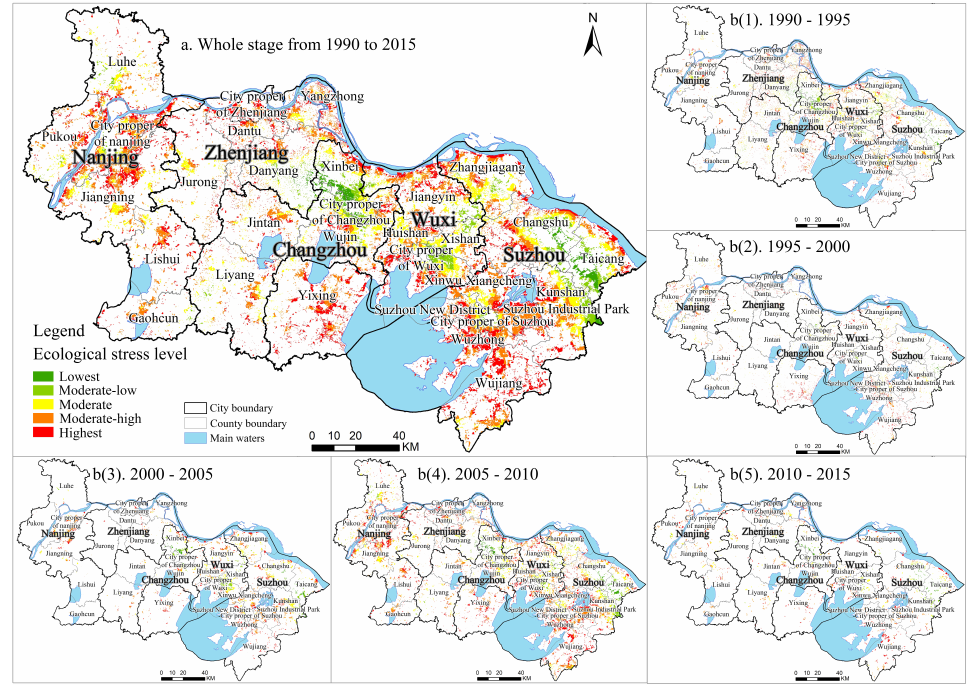
Figure 6. Spatial distribution of construction lands associated with different ecological stress levels in each